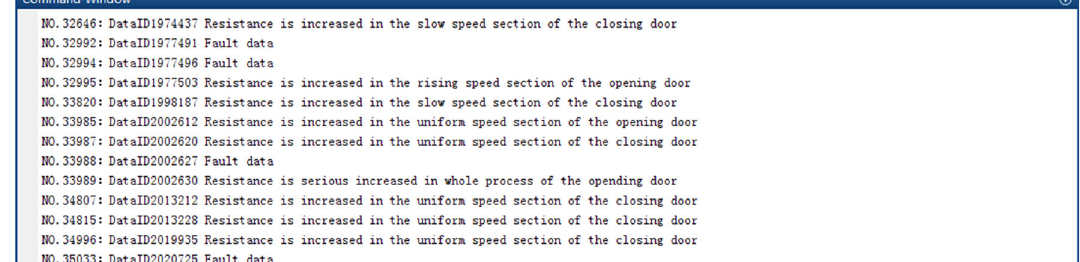
Fig. 11 MATLAB real-time diagnosis